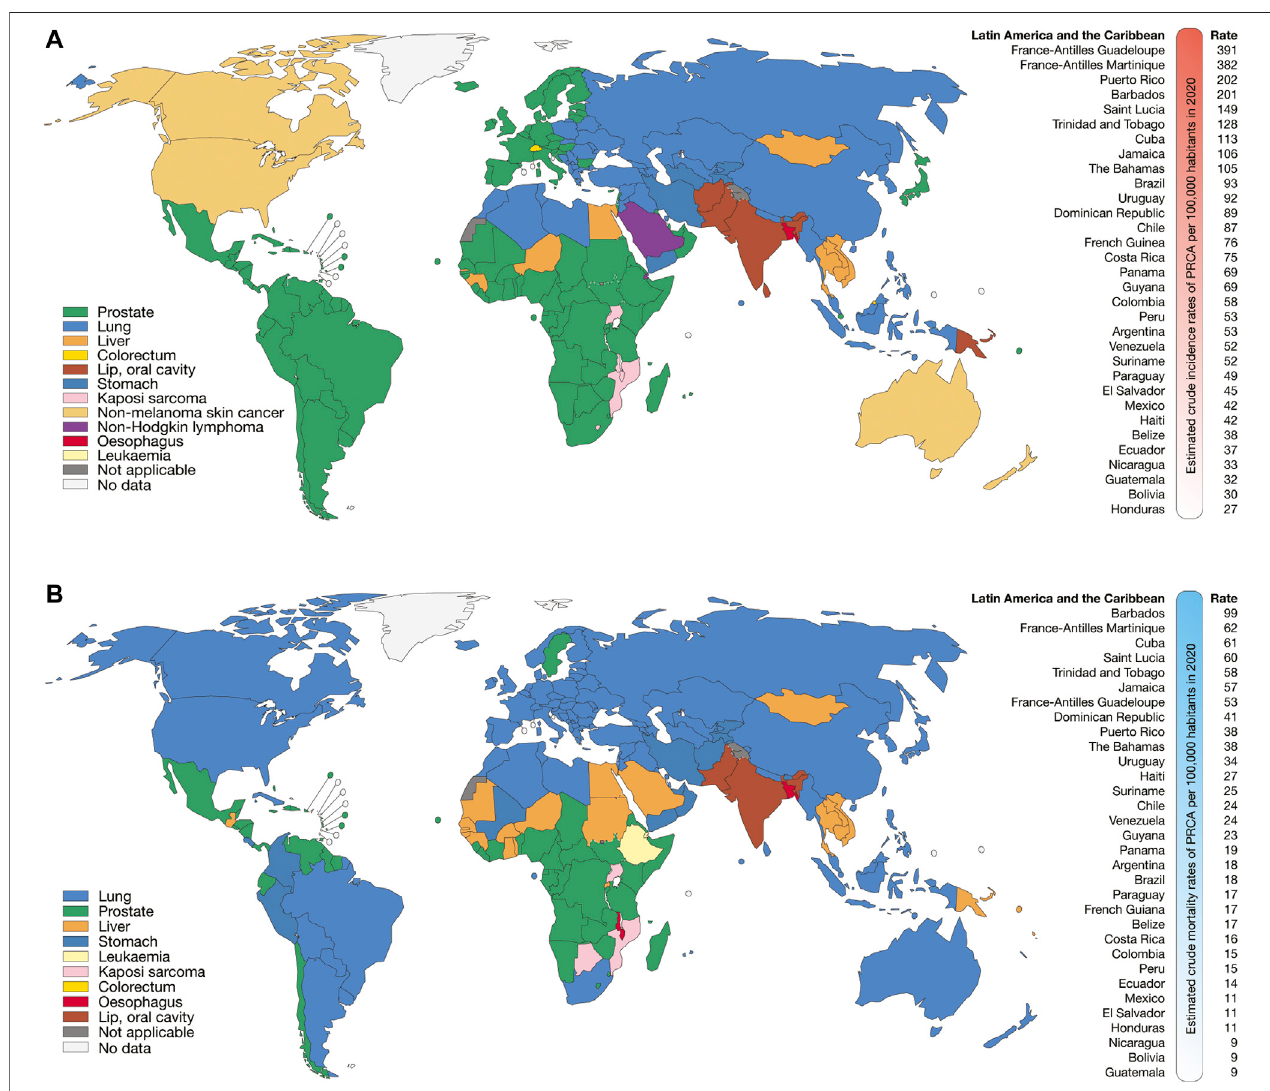
FIGURE2| EpidemiologyofPRCA. (A) Topcancercrudeincidenceper countryinmales ofallages (left) ,and ranking ofestimated crudeincidence ratesofPRCA per 100,000 inhabitants in Latin American and the Caribbean countries (right) . (B) Top cancer mortality per country in males of all ages (left) , and ranking of mortality crude rates of PRCA per 100,000 inhabitants in Latin American and the Caribbean countries (right) .